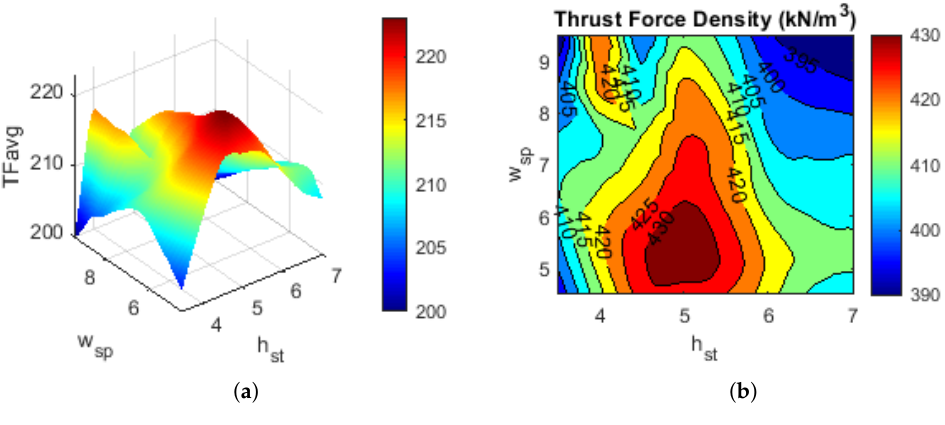
Figure 11. Influence of h st and w sp on ( a ) TF avg ( b ) TFD .